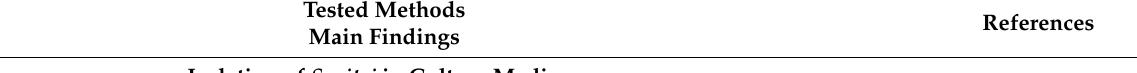
Table 4. Cont. Tested